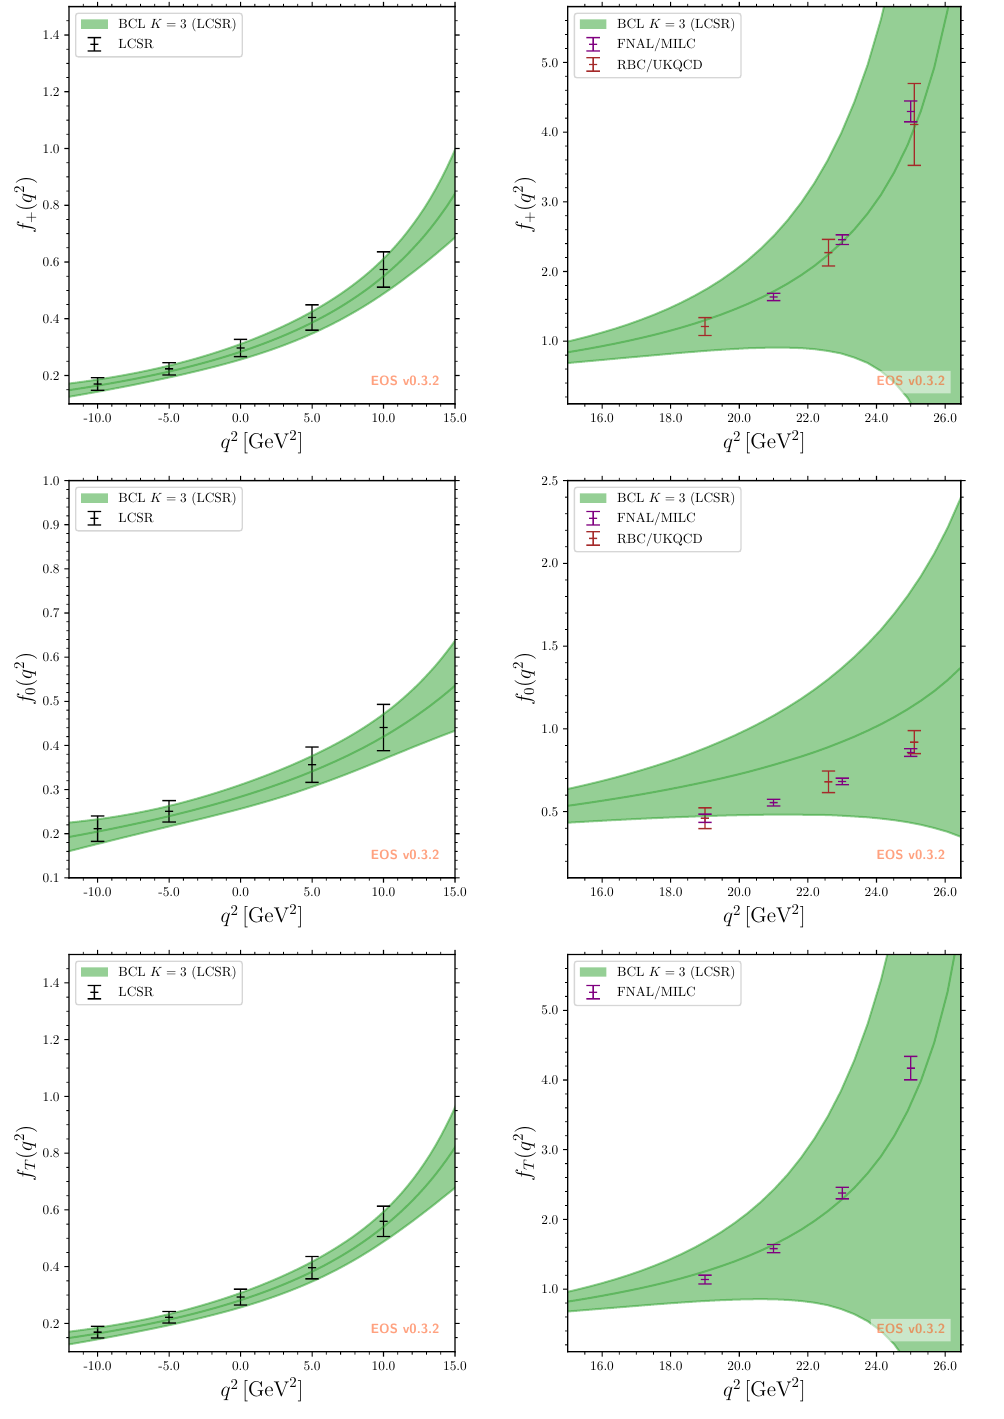
Figure 3 . Posterior-predictions for the form factors f + (top), f 0 (center), and f T (bottom) obtained from our fits of the common BCL parametrization (3.4) to only the LCSR pseudo data points discussed in section 2. Lattice QCD points are merely shown for illustrative purpose. The bands correspond to the envelope at 68%